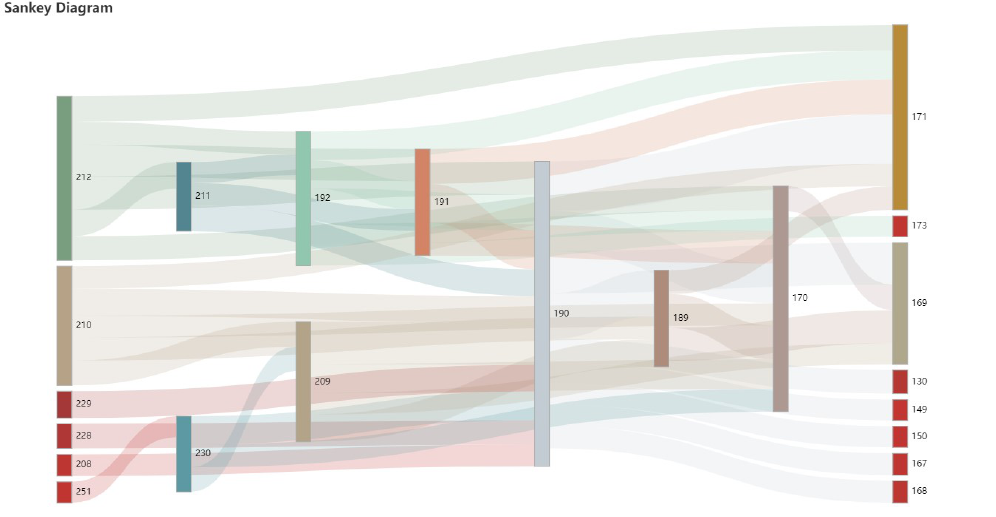
Figure 11. Scale-free characteristics and flow analysis of fine particle network.